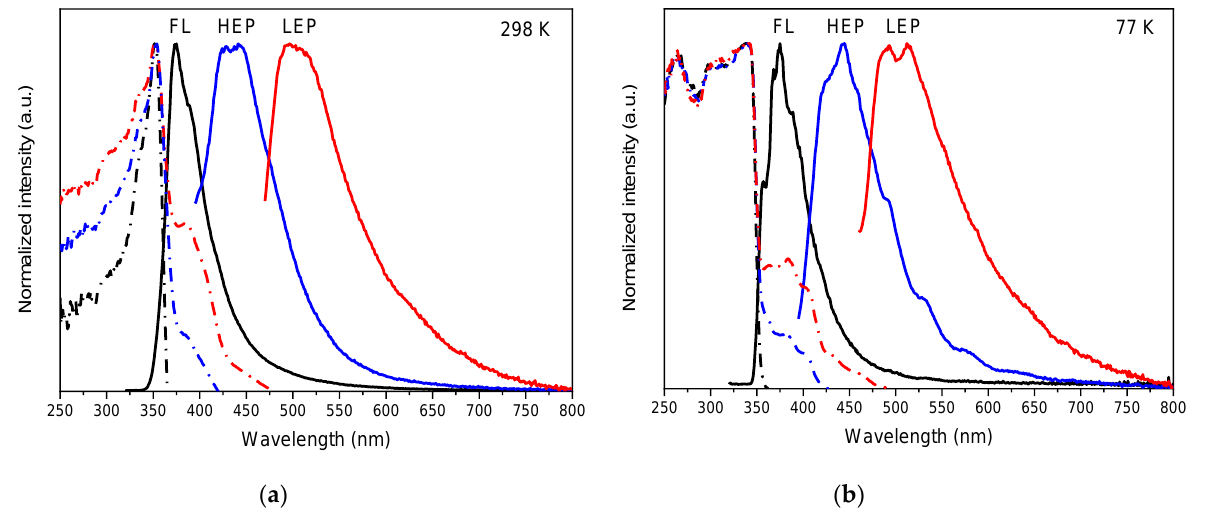
Figure 4. Normalized PL emission (continuous lines) and excitation (dashed–dotted lines) spectra of ground crystals of TT-HThio : ( a ) 298 K, emission at λ exc = 300 nm (black), 376 nm (blue), 450 nm (red), excitation at λ em = 365 nm (black), 434 nm (blue), 597 nm (red); ( b ) 77 K, emission at λ exc = 300 nm (black), 376 nm (blue), 440 nm (red), excitation at λ em = 375 nm (black), 443 nm (blue), 513 nm (red). In diluted DCM solutions (1 × 10 − 5 M), TT-(HThio) 3 displays a single fluorescence (FL, = 5%, λ em = 380 nm, = 1.17 ns at 298 K and λ em = 370 nm, 1.42 ns at 77 K, Figures 5, S20, S2311). In PMMA-blended films (0.5 w% TT-(HThio) 3 ), one fluorescence (FL, = 17%, λ em = 372 nm, = 0.90 ns at 298 K, Figures 5 and S28) is observed in exactly the same position as that measured in DCM at 77 K. 250300350400450500550600650 N o r m a li z ed I n t en s i t y ( a . u . ) W a v e l eng t h ( n m ) N o r m a li z ed I n t en s i t y ( a . u . )